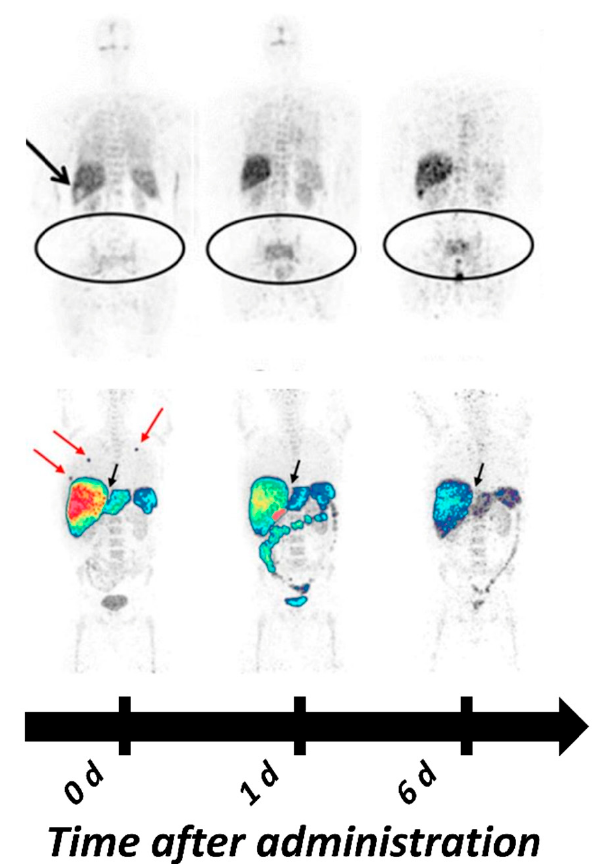
Figure 1. Imaging of HER1 expression in patients using 89 Zr-labeled monoclonal antibodies cetuximab (upper row) [75] and panitumumab (bottom row) [81]. Photopenic lesions in liver are indicated with black arrows; accumulation in lungs pointed with red arrows, resolved with time. These images were originally published in Oncotarget [75] and Am J Nucl Med Mol Imaging